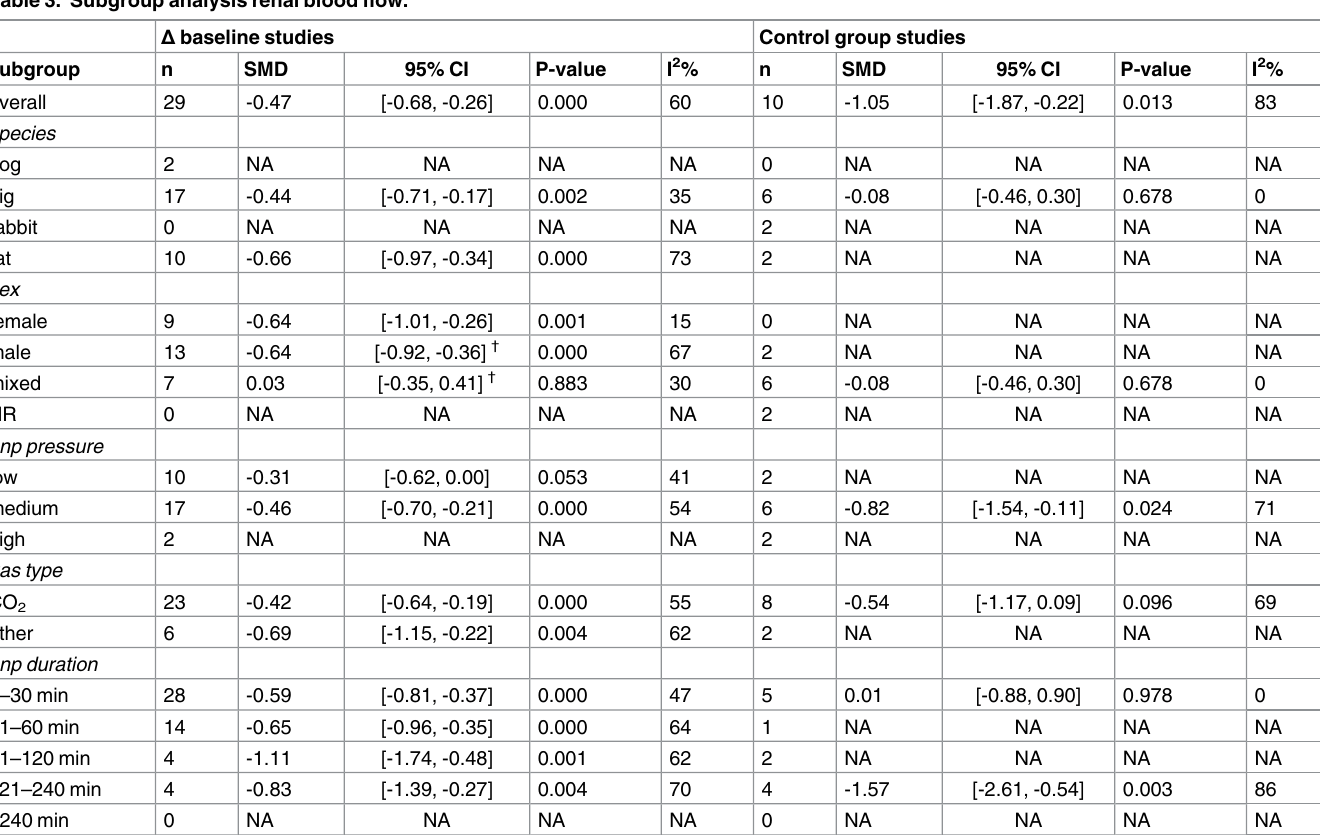
Table 3. Subgroup analysis renal blood